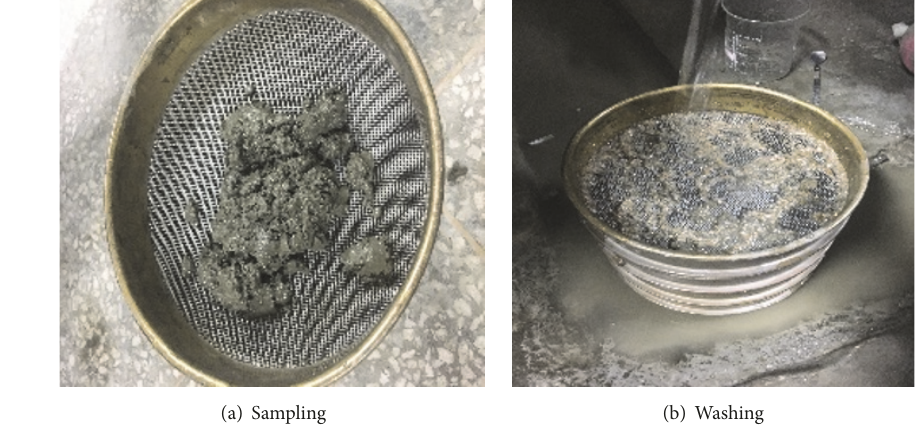
Figure 15: Washing test of SHCs.